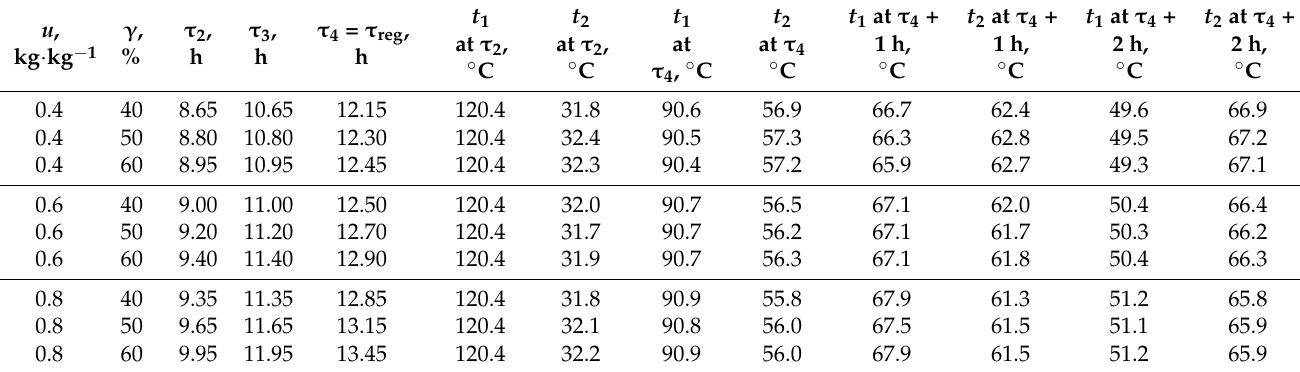
Table 1. Changes in the Duration of the Steaming Regimes τ reg for Autoclave Steaming at t m1 = 130 ◦ C of Beech Prisms with t w0 = 0 ◦ C and d × b = 0.4 × 0.4 m, Depending on Moisture Content u and Loading Level γ .